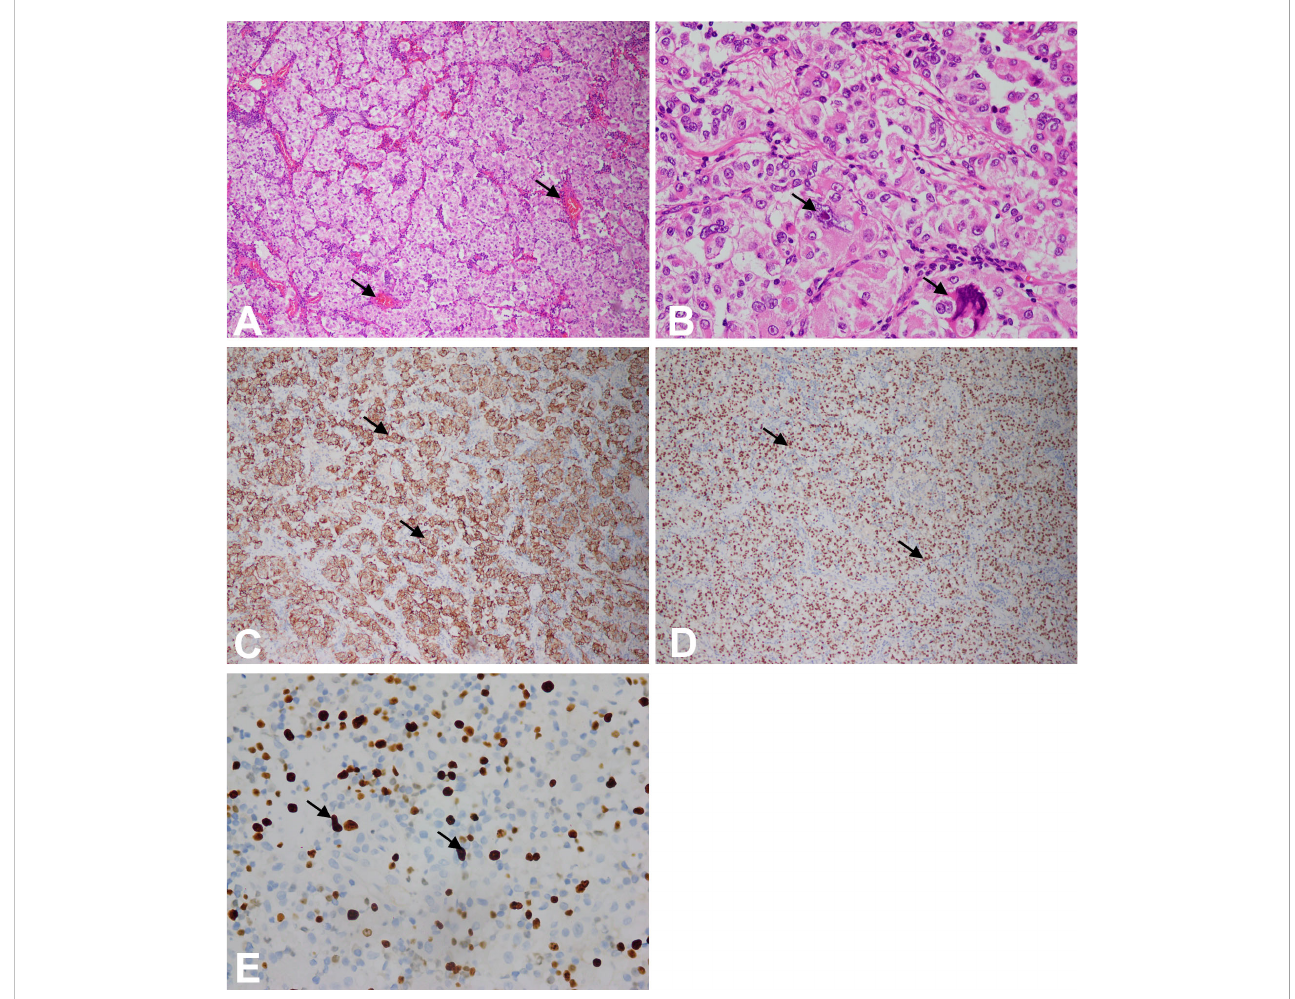
FIGURE 3 (A) Microscopic features of the tumor at 10× magni fi cation using microscope. The tumor consisted of nests of epithelioid cells with clear-to-eosinophilic granular cytoplasm, as pointed by arrowheads. (B) Microscopic features of the tumor at 40× magni fi cation using microscope. The tumor cells had large nuclei with prominent nucleoli, and the local atypia of tumor cells was obvious, as pointed by arrowheads. (C) The tumor cells were immunoreactive for HMB-45, and yellow was positive in the cytoplasm, as pointed by arrowheads (at 10× magni fi cation using microscope). (D) The tumor cells were immunoreactive for TFE-3, and yellow was positive in the nucleus, as pointed by arrowheads (at 10x magni fi cation using microscope). (E) Ki67 immunohistochemistry at 40× magni fi cation using